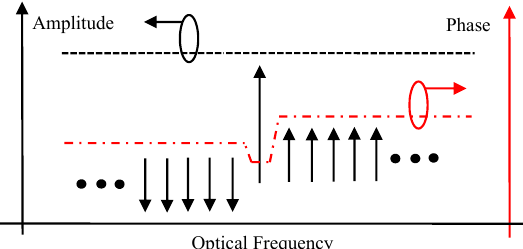
Figure 8. The carrier and the RF modulation sidebands at the input of the LCOS based optical processor, together with the LCOS based optical processor amplitude and phase response profile designed for improving the phase shifter signal-to-noise ratio (SNR) performance.